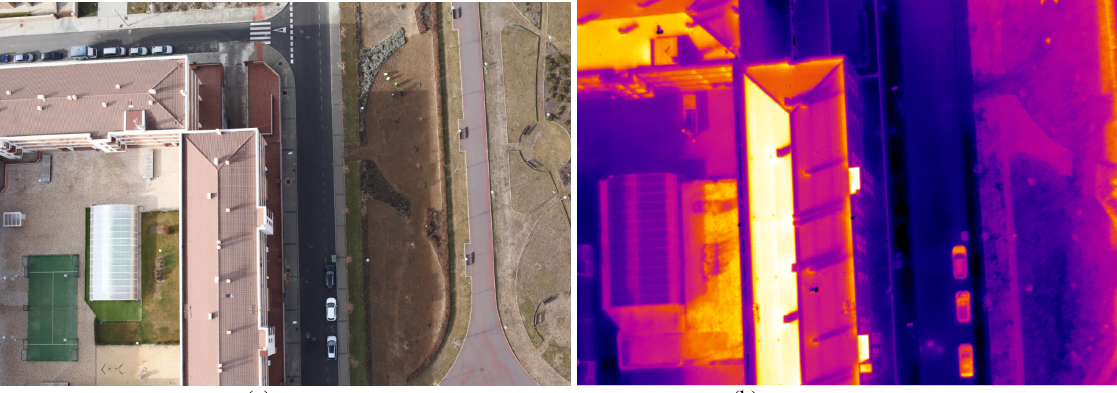
Figure 6: An example of visible (a) and thermal (b) images acquired with a manned ultra-light motor and that need to be automatically co-registered by finding homologues points.